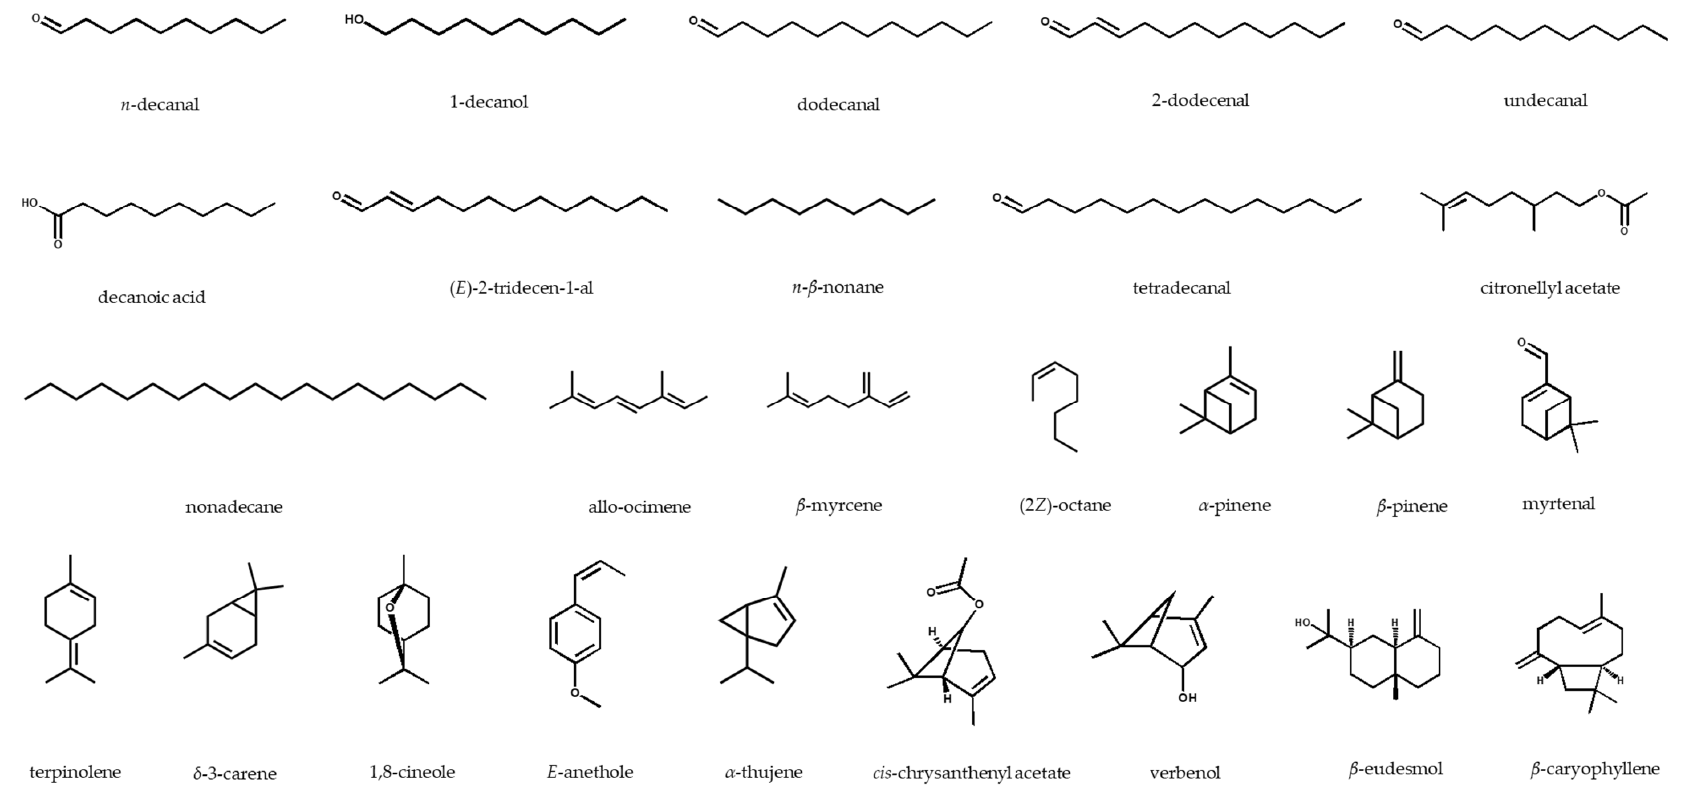
Figure 2. Chemical structures of the major essential oil compounds identified in the Ducrosia genus.